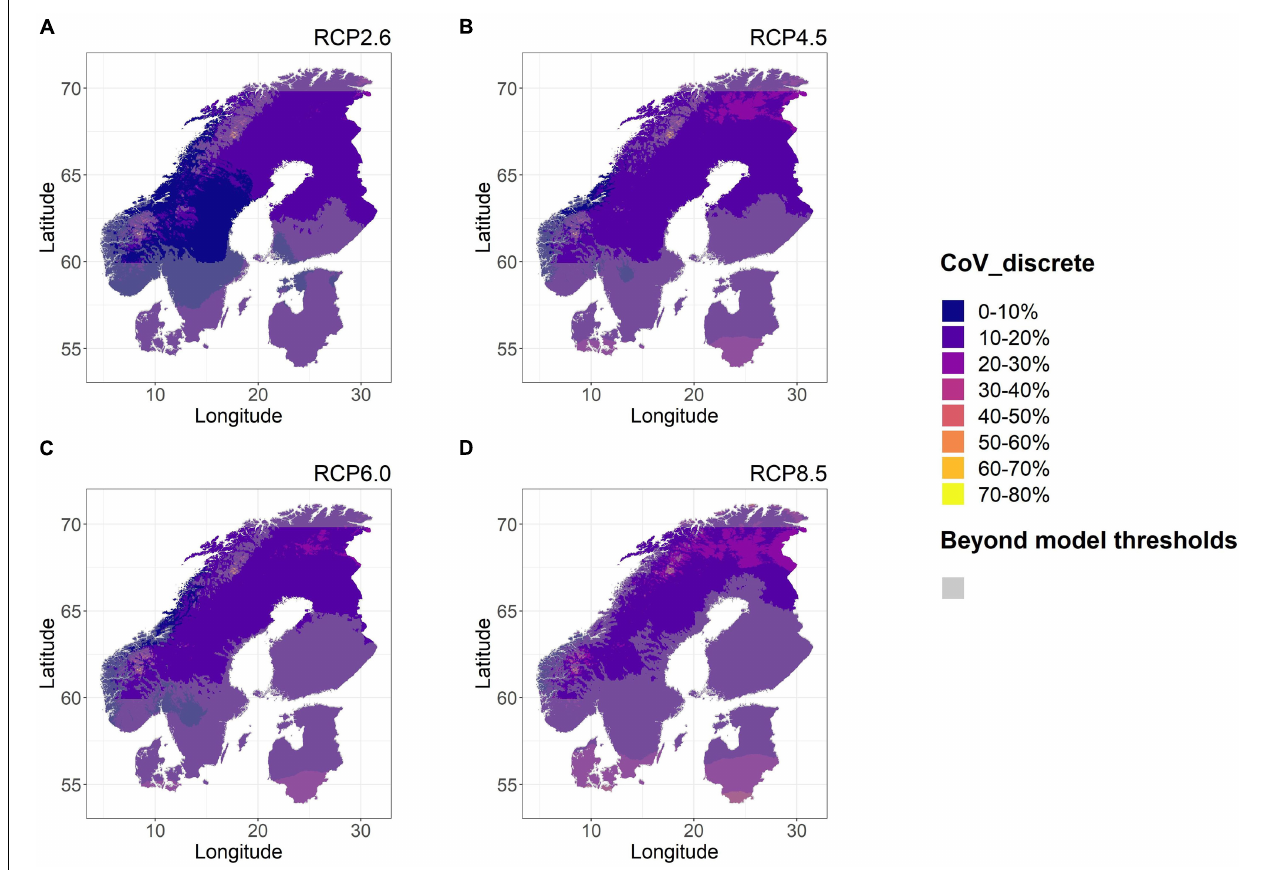
FIGURE 6 | Coefficients of variation (CoV) for Scots pine tree height among GCMs, calculated for each 1 km × 1 km prediction and for each RCPs 2.6 (A) , 4.5 (B) , 6.0 (C) , and 8.5 (D) in the Nordic region. All locations where environmental variables exceeded the model data range according to three GCMs or more have been dimmed in semi-transparent